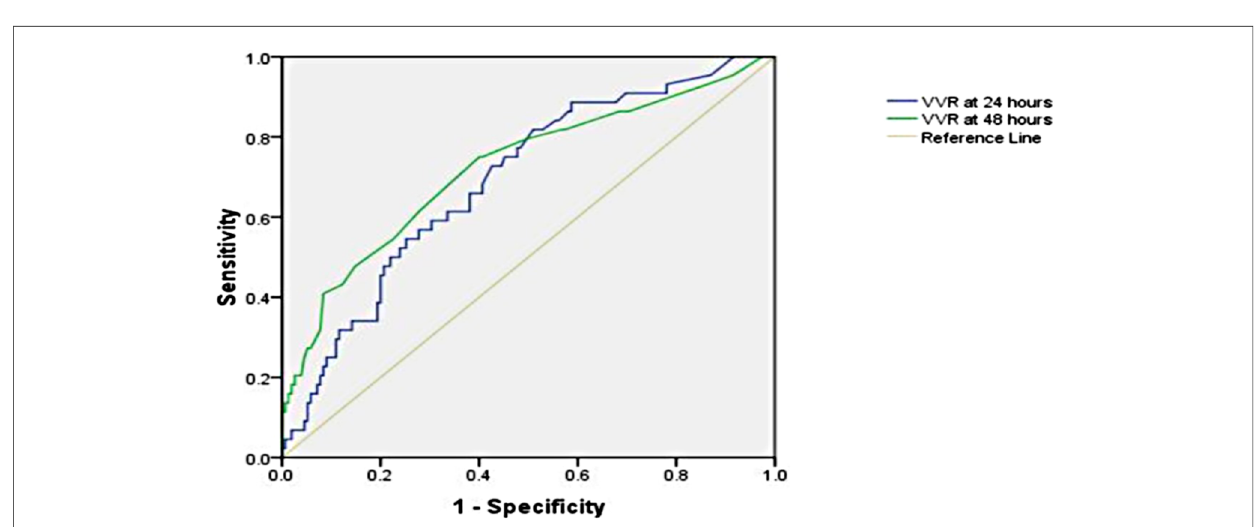
FIGURE 2 Receiver operating characteristic curve for the prolonged length of hospital stay and vasoactive-ventilation-renal score at 24 h and 48 h